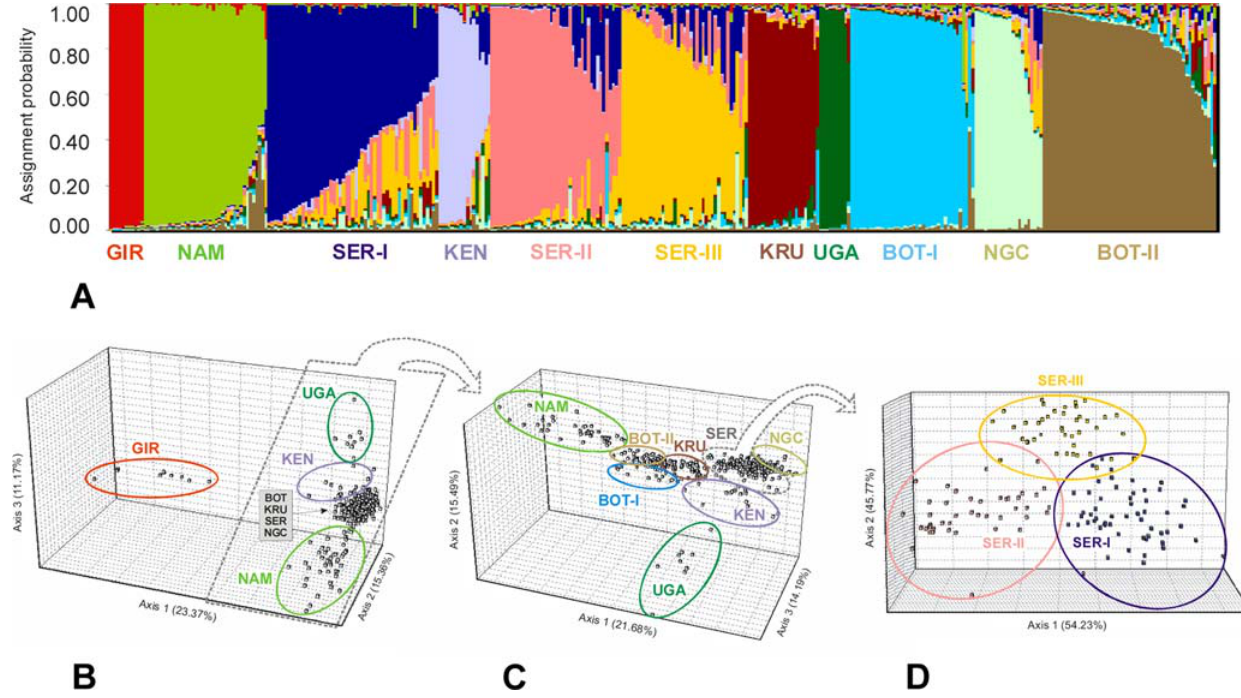
Figure 2. Population structure analyses in lions. (A) Bayesian population assignment test [22] of the 357 lions using 24 nDNA loci ( ADA , TF , and 22 microsatellites) and mtDNA data, and considering K =11 (11 populations). (B) Three-dimensional factorial correspondence analysis [23] (FCA) based on the 24 nDNA loci genotypes in the 357 lions. Axe 1, 2, and 3 represent 49.90% of the genetic variation observed. (C) FCA representation excluding the GIR lions. Axe 1, 2, and 3 represent 51.35% of the genetic variation observed. (D) FCA representation considering only the SER lions supportive of a three distinct population clusters subdivision (SER-I, SER-II, and SER-III).